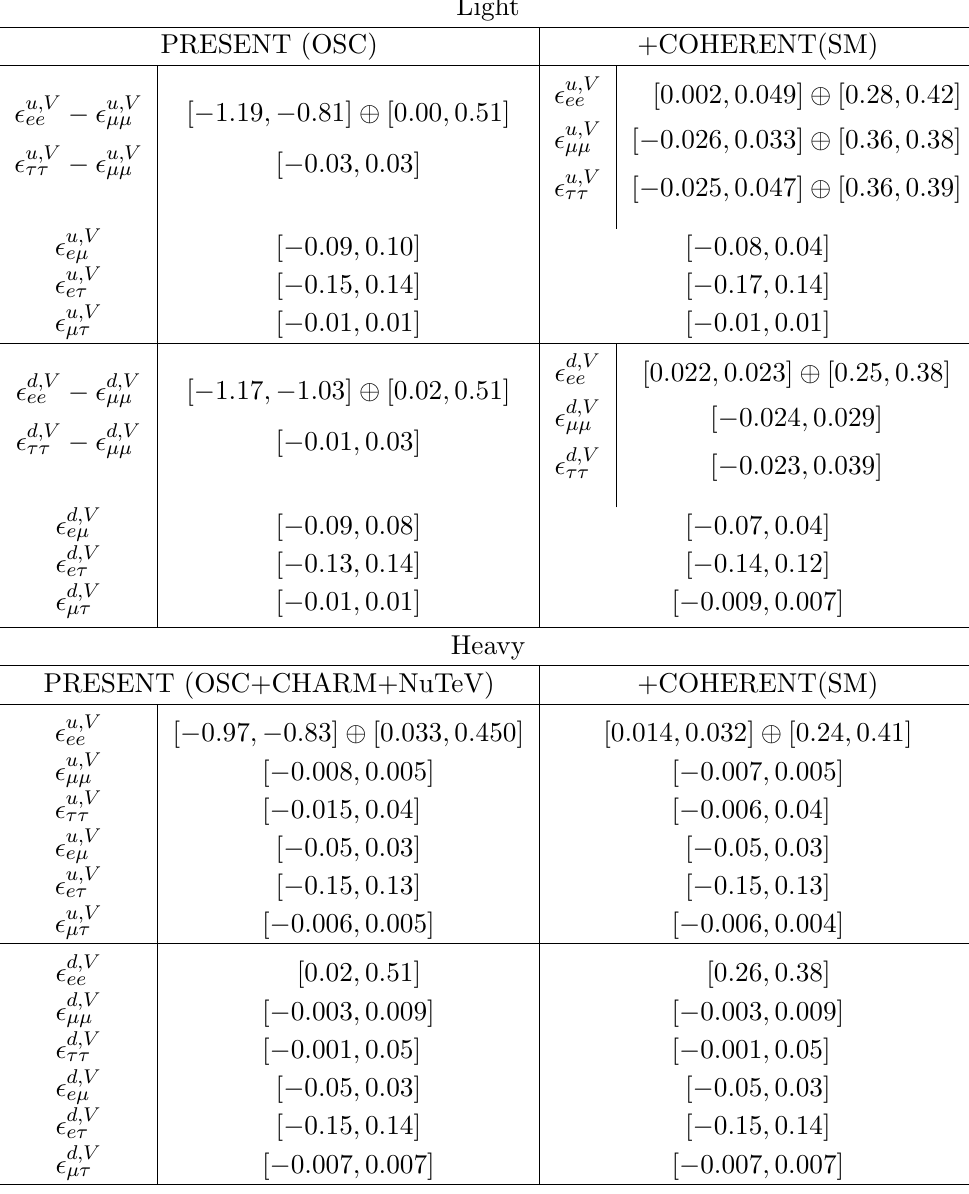
for f = u; d as obtained from the (cid:11)(cid:12)